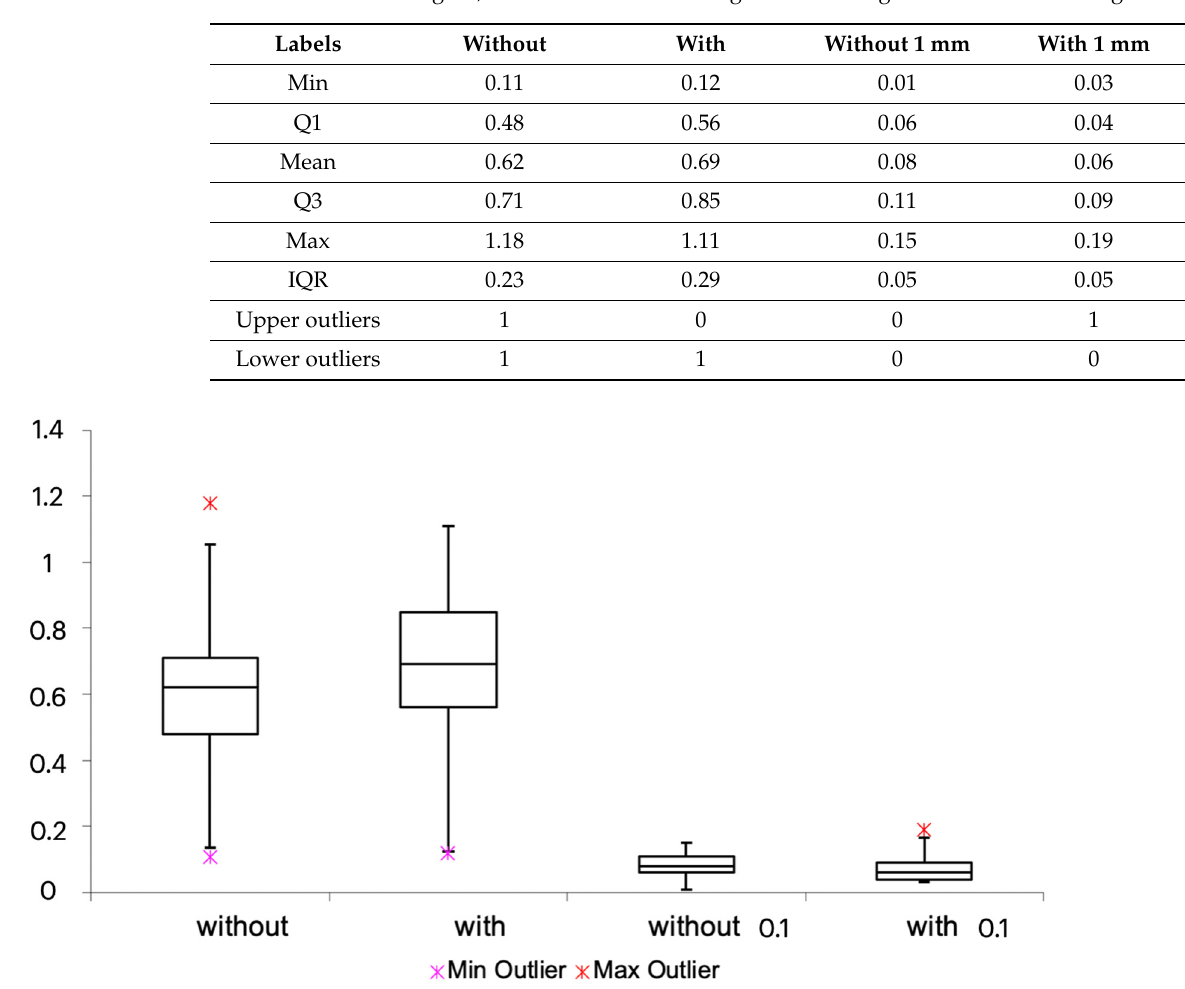
Figure 2. Graph of the average of the weights obtained. Table 2. Standard deviations and t -test of data. “without” means weight after drying without clear aligner; “with” means weight after drying with clear aligner; “without 1 mm” means weight after sieving at 1 mm without clear aligner; “with 1 mm” means weight after sieving at 1 mm with clear aligner. Without With p -Value Without 1 mm With 1 mm p -Value 0.62 ± 0.21